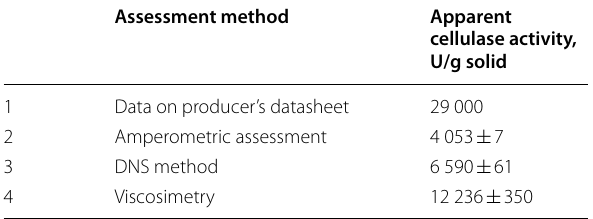
Table 2 The apparent cellulase activity of a commercial cellulase preparation (TCI Chemicals) Assessment